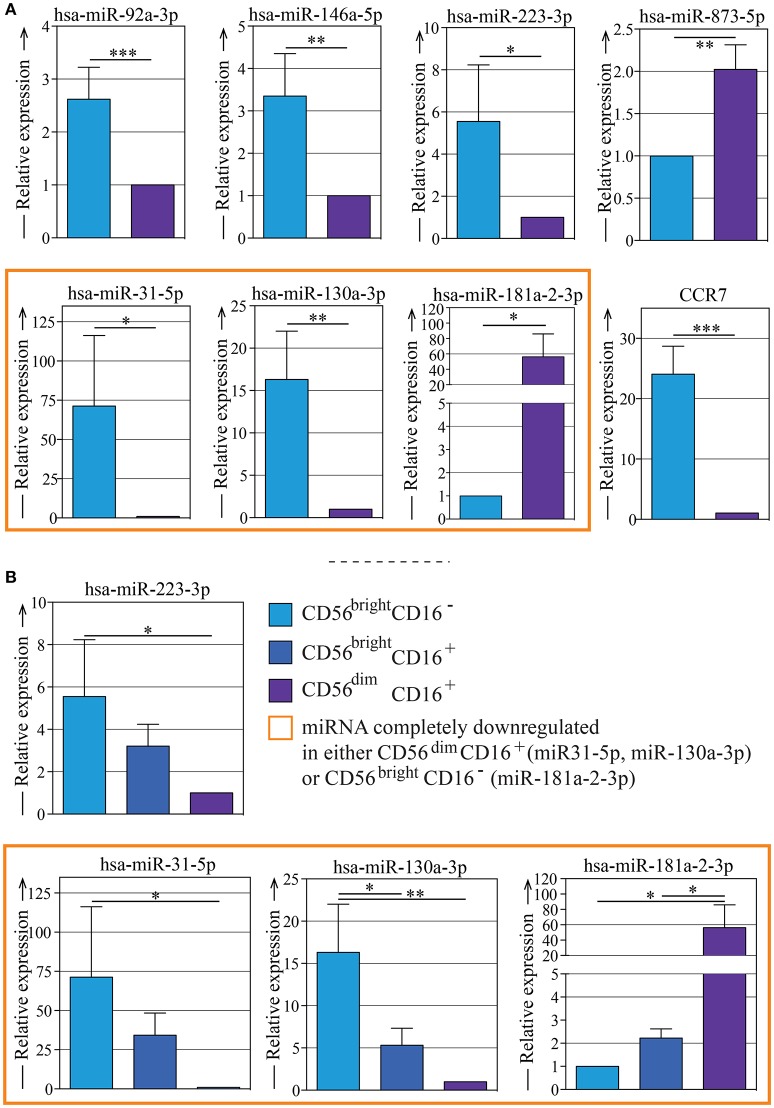
Quantitative RT-PCR validation of the expression of seven of the most regulated miRNAs on different NK subsets. (A) Quantitative RT-PCR validation of the expression of miR-92a-3p, miR-146a-5p, miR-223-3p, miR-873-5p, miR-31-5p, miR-130a-3p, and miR-181a-2-3p in CD56bright/CD16− and CD56dim/CD16+ NK cell subsets. The qRT–PCR experiment was performed using samples prepared separately from the microarray experiment. Quantitative evaluation of CCR7 mRNA transcripts in human CD56bright and CD56dim NK cells by real-time RT-PCR was used as control. Data represents the mean ± SEM, n = 3 donors. T-test analysis comparing CD56bright CD16− and CD56dim CD16+ NK cell subsets indicated as *p < 0.05, **p < 0.01, *** p < 0.001. (B) Quantitative RT-PCR validation of the expression of miR-223-3p, miR-31-5p, miR-130a-3p, and miR-181a-2-3p in CD56bright/CD16−, CD56bright/CD16+, and CD56dim/CD16+ NK cell subsets. The qRT–PCR experiment was performed using samples prepared separately from the microarray experiment. Data represent the mean ± SEM, n = 3 donors. One way Anova with Bonferroni's post-test comparing the three NK cell subsets indicated as *p < 0.05, **p < 0.01. Color legend: CD56bright/CD16− NK cells are indicated in light blue, CD56bright/CD16+ NK cells are indicated in dark blue, CD56dim/CD16+ NK cells are indicated in purple,and the miRNAs that can be considered completely down-regulated in either CD56bright/CD16− or CD56dim/CD16+ are indicated with an orange frame.